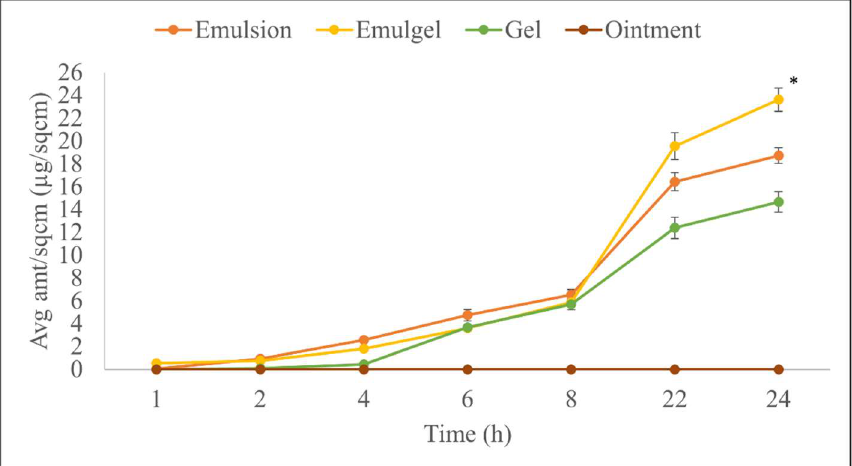
Figure 7. In vitro permeation comparison of different semi-solid formulations, * indicates p < 0.01 and statistically significant in comparison to all other formulations. Data shown are Mean ± SE of six replicates.